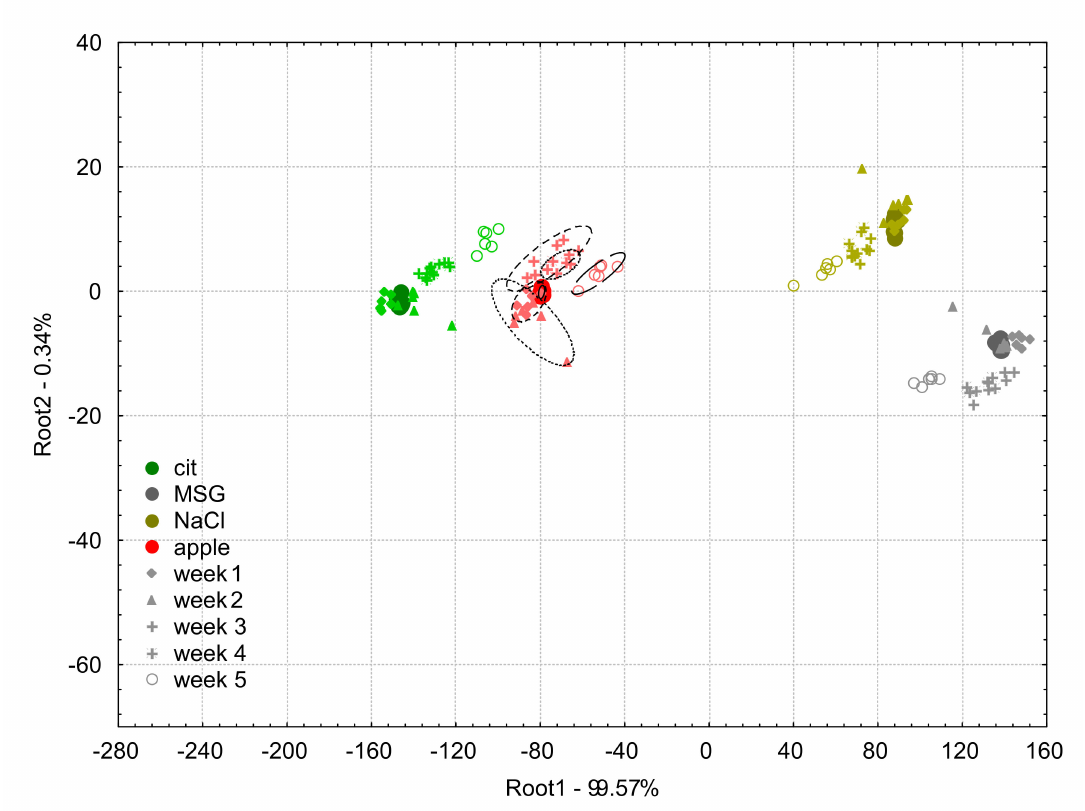
Figure 6. Linear discriminant analysis plots for the drift corrected dataset using the additive correction relative to the whole dataset method of the e-tongue measurements of apple juice samples (red symbols) and model solutions: citric acid (green symbols), NaCl (gold symbols), and MSG (gray symbols). The solid circles indicate the measurements on week 0 which was used to build the linear discriminant analysis model, and the di ff erent symbols (diamond, triangle, plus, asterisk, and circle) stand for the di ff erent weeks 1–5,